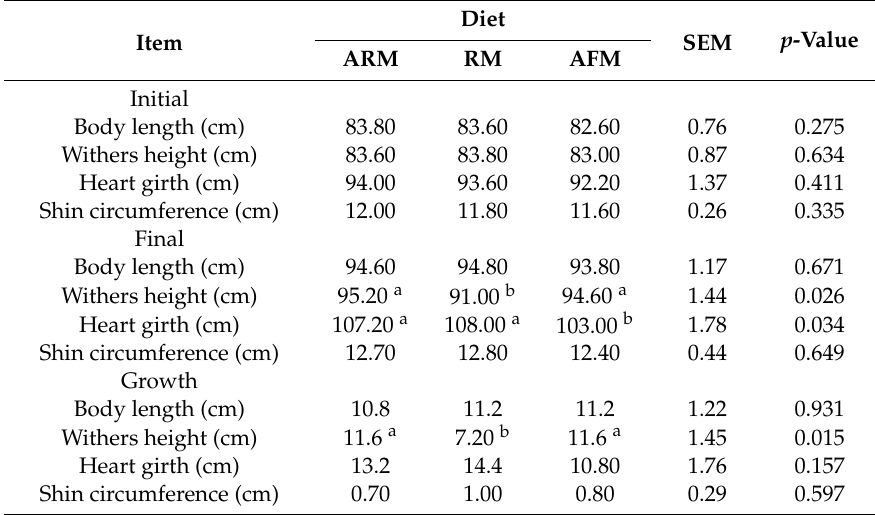
Table 5. Body measurements of dairy calves fed di ff erent types of